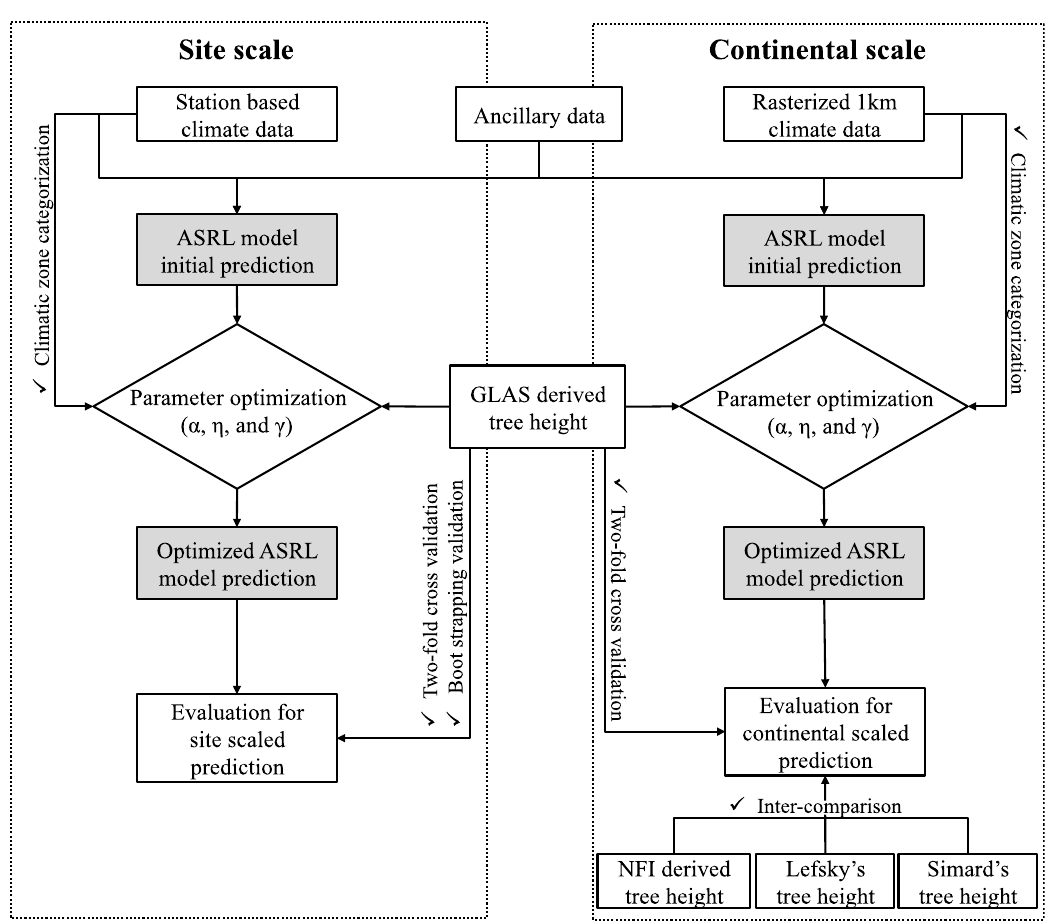
Figure 2. Overall scheme of research. The performances of the optimized ASRL model was examined over the CONNA. This study was divided into tests at the site and continental